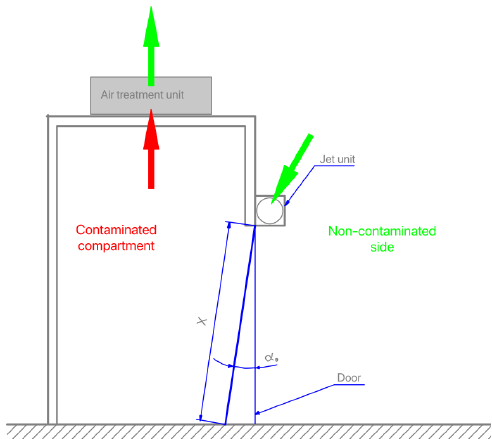
Figure 1. Illustration of the working principle of the aerodynamic sealing for containing a contami- nant within a compartment.